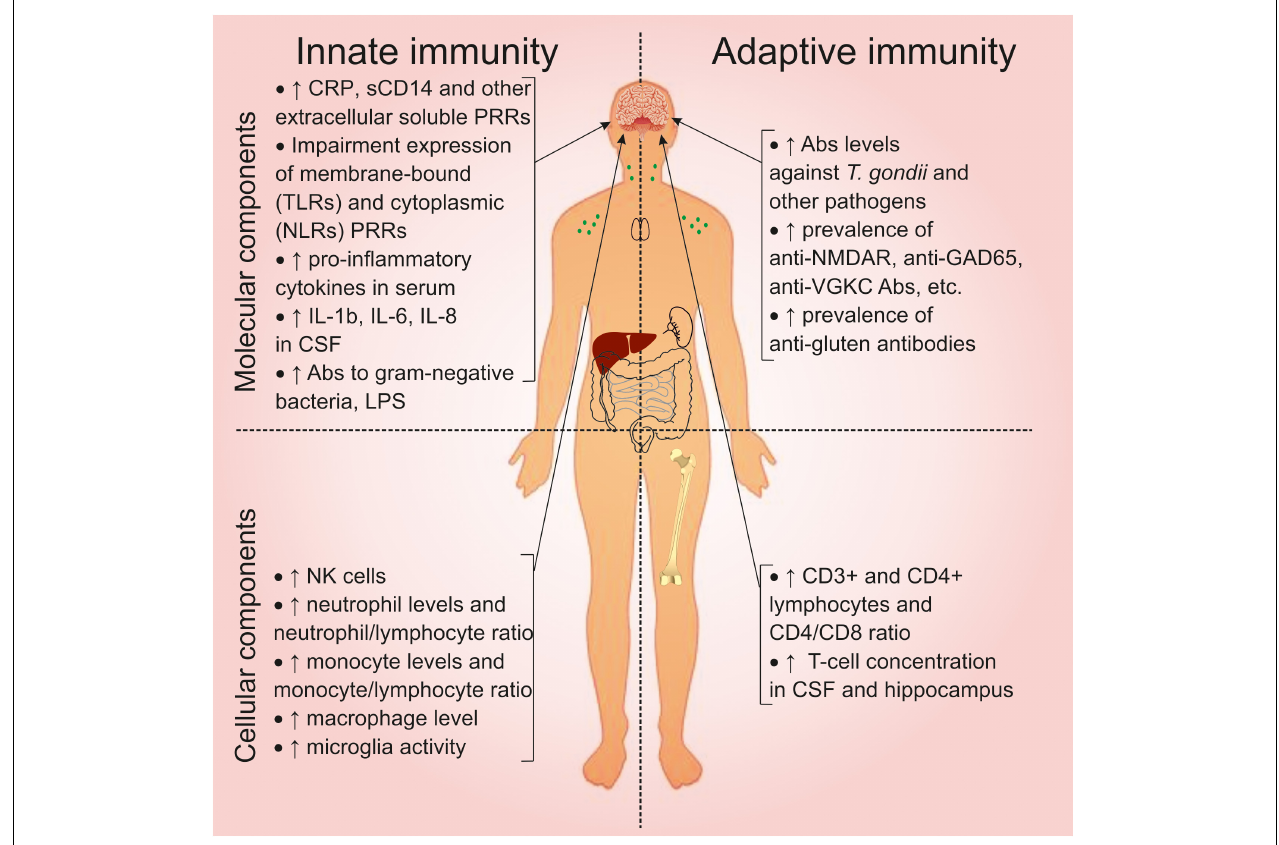
FIGURE 3 | Overview of the immune system abnormalities associated with schizophrenia. CRP, C-reactive protein; CD, cluster of differentiation; PRRs, pattern recognition receptors; TLRs, toll-like receptors; NLRs, (NOD)-like receptors; IL, interleukin; CSF, cerebrospinal fluid; LPS, lipopolysaccharide; NK, natural killer; NMDAR, N-methyl-D-aspartate receptor; GAD, glutamic acid decarboxylase; VGKC, voltage-gated potassium